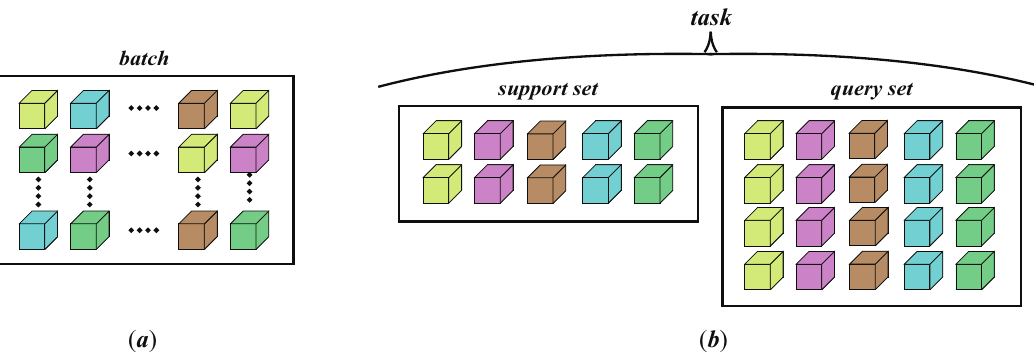
Figure 2. Different training and learning strategy where color represents class. ( a ) Batch-based training strategy used widely in deep learning. ( b ) Task-based learning strategy used in